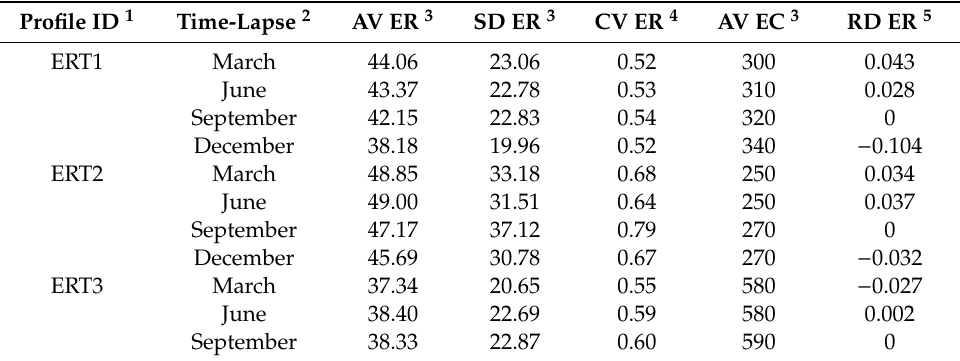
Table 6. Time-lapse ER models